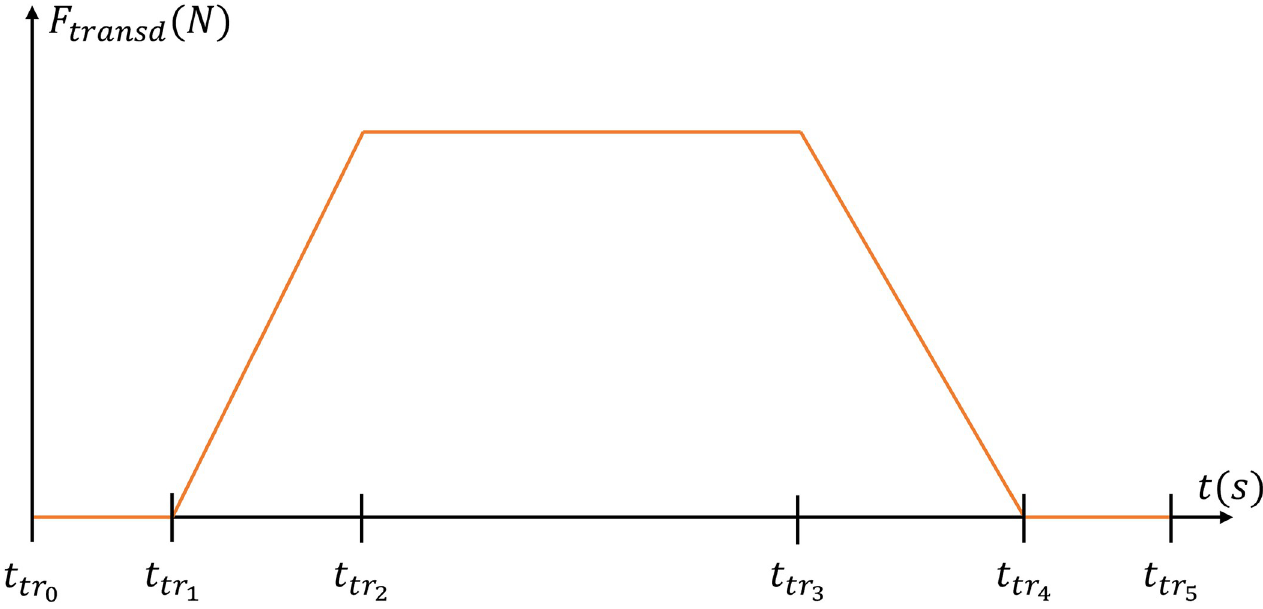
Fig 2. Definition of times t